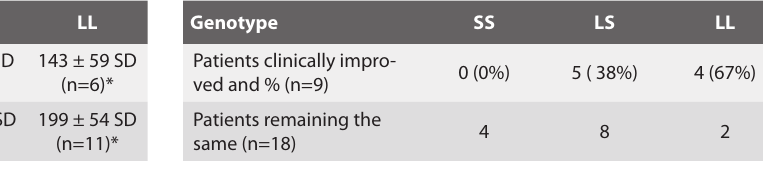
Table 6. Serotonin levels in female patients are lower than those in female controls (µg/L). The difference between patients and controls is statistically significant for those having the LL genotype (student’s t test p<0.03).